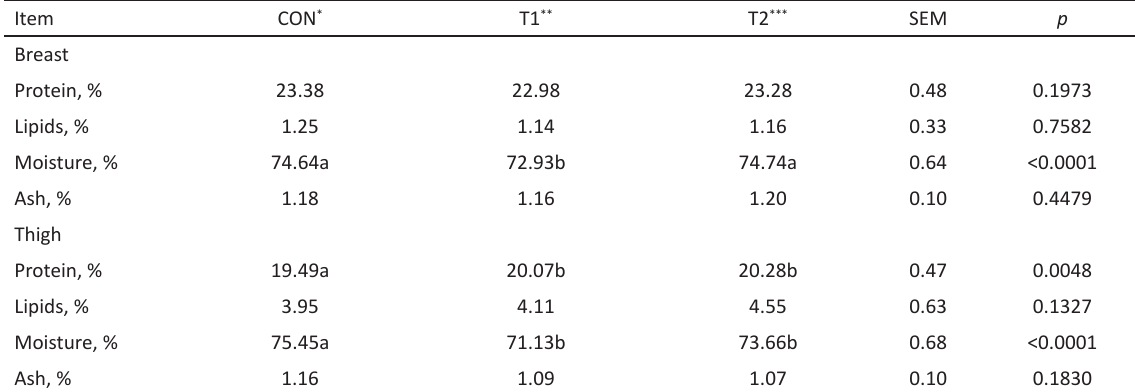
Table 5. Proximate composition of the breast and thigh meat